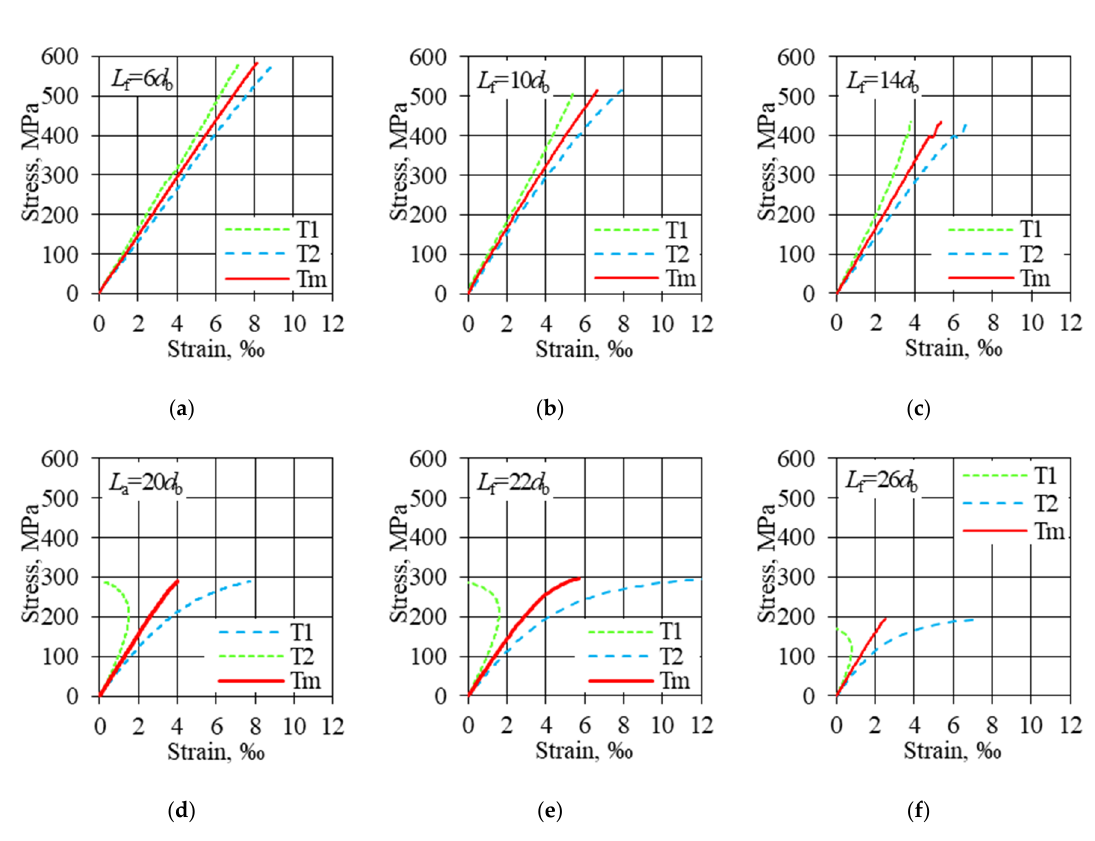
Figure 10. Stress–strain relationship (absolute value): ( a ) L f = 6 d b crushing of the specimen; ( b ) L f = 10 d b crushing the sample; ( c ) L f = 14 d b initial buckling followed by crushing; ( d ) L f = 20 d b buckling without visible crushing; ( e ) L f = 22 d b buckling without crushing; ( f ) L f = 26 d b buckling without visible crushing.